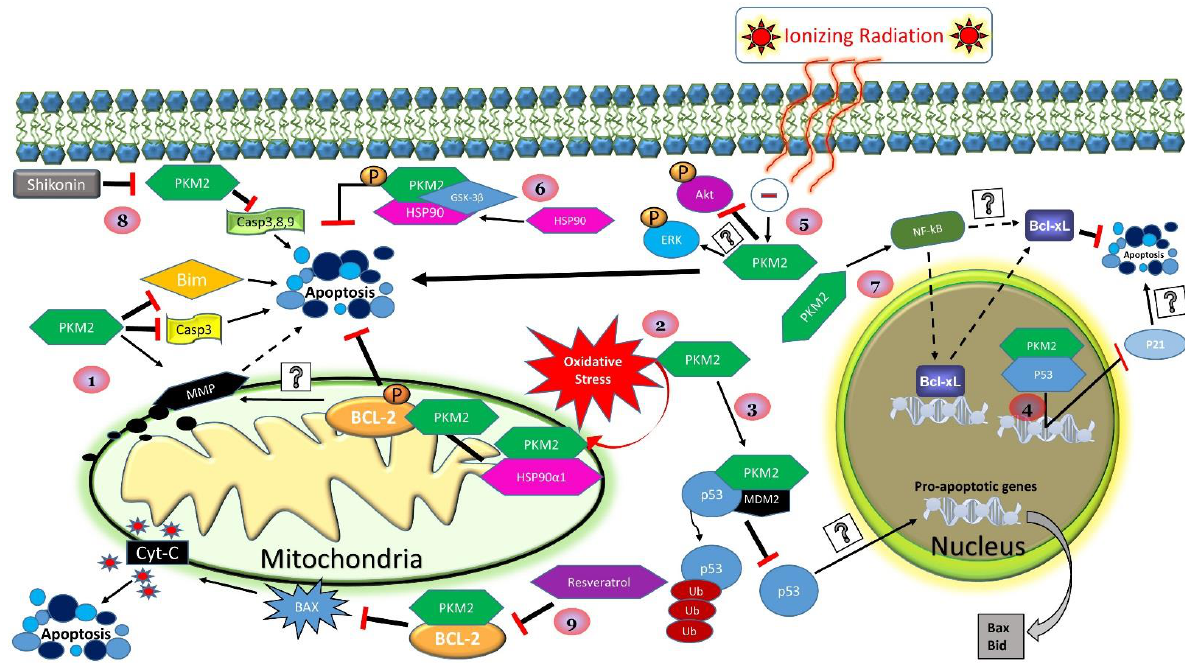
Figure 1. Intrinsic role of PKM2 in apoptotic cancer cell death. ( 1 ) PKM2 knockdown induces apoptosis through the stabilization of Bim, decreases in mitochondrial membrane potential (MMP), and the activation of Caspase-3 [112]. ( 2 ) H 2 O 2 -induced oxidative stress promotes the mitochondrial translocation of PKM2, where it is then chaperoned by HSP90α1 in order to phosphorylate and stabilize Bcl2 [91]. ( 3 ) PKM2 forms a complex with p53 and MDM2, a master regulator protein of pro-apoptotic genes [116]. ( 4 ) In the nucleus, PKM2 interacts with P53 to reduce P53 transcriptional activity and suppress P53-induced P21 transactivation [117]. ( 5 ) Ionizing radiation-induced apoptosis is enhanced in PKM2 knockdown cells concomitant with reduced Akt phosphorylation and increased levels of phosphorylated ERK [118]. ( 6 ) HSP90 mediates the complex of PKM2 and glycogen synthase kinase-3β (GSK-3β), leading to the subsequent PKM2 phosphorylation and the inhibition of apoptosis [119]. ( 7 ) PKM2 knockdown decreases Bcl-xL gene transcription, potentially through PKM2 stabilization of NF-κB [111]. ( 8 ) Modulation of PKM2 levels and/or activity alters the cleavage/activation of caspases 3, 8, and 9 to increase apoptosis [112,120]. ( 9 ) Inhibition of PKM2 induces apoptosis through altering the Bax/Bcl-2 ratio and the subsequent release of cytochrome c from the mitochondria [121].